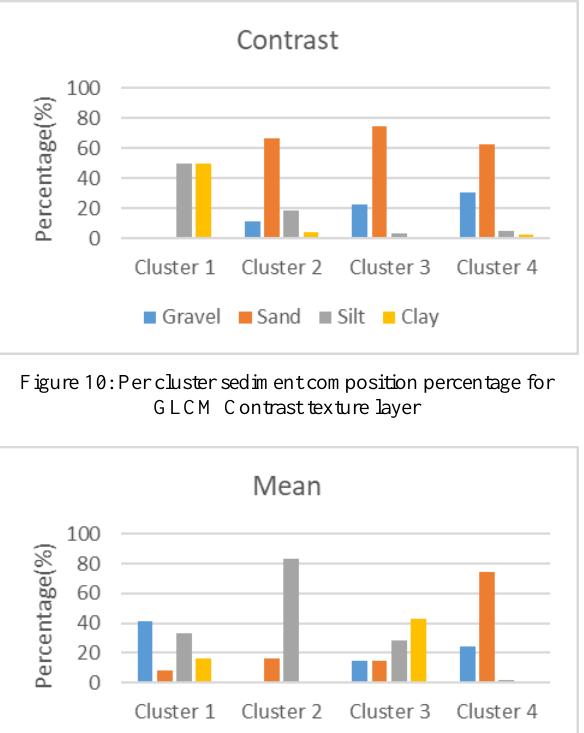
Table 6: Cross tabulation between the GLCM Mean cluster map and ground truth observations